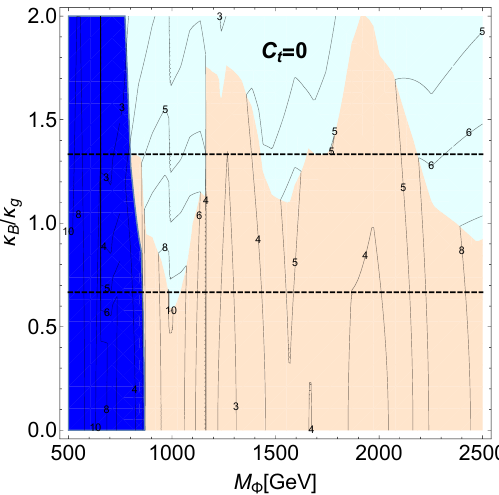
Figure 13 . Observed bounds on color octet single production in the M (cid:8) vs. (cid:20) B =(cid:20) g plane. The dark blue area is excluded from pair production bounds, while the orange (cyan) area labels where the dominant bound arises from the jj ( j(cid:13) ) search. Contours show the upper bound on (cid:20) g =f (cid:8) in TeV (cid:0) 1 . For reference, the horizontal dashed lines indicate (cid:12)xed (cid:20) B =(cid:20) g ratios of 2 = 3 (lower) and 4 = 3